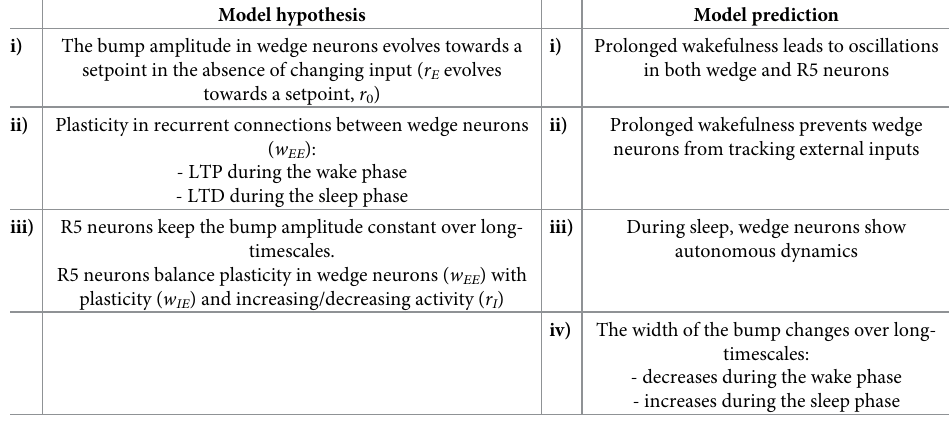
Table 1. Model hypothesis and predictions. Model hypothesis Model